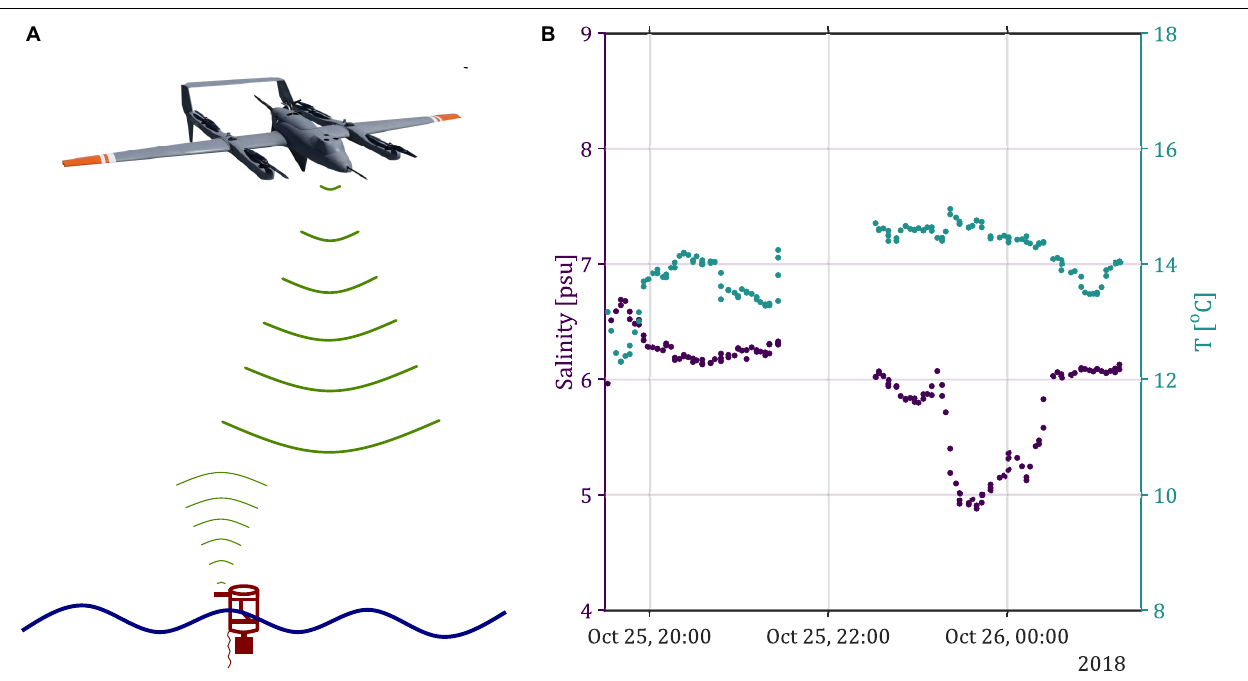
FIGURE 12 | (A) Representation of the DD µ D in the water with its thermistor chain unfurled. (B) Time series of nearest-surface water temperature (teal) and salinity (violet) from an example deployment. Data were not recorded during the short gap in the time series.